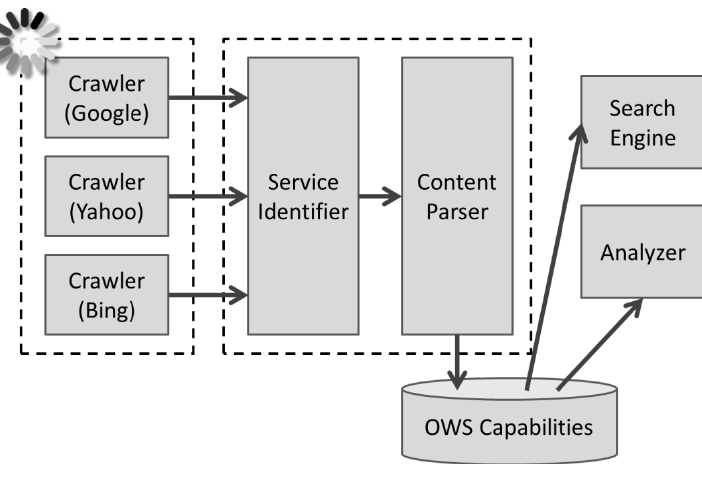
Figure 4. The GeoCENS search engine